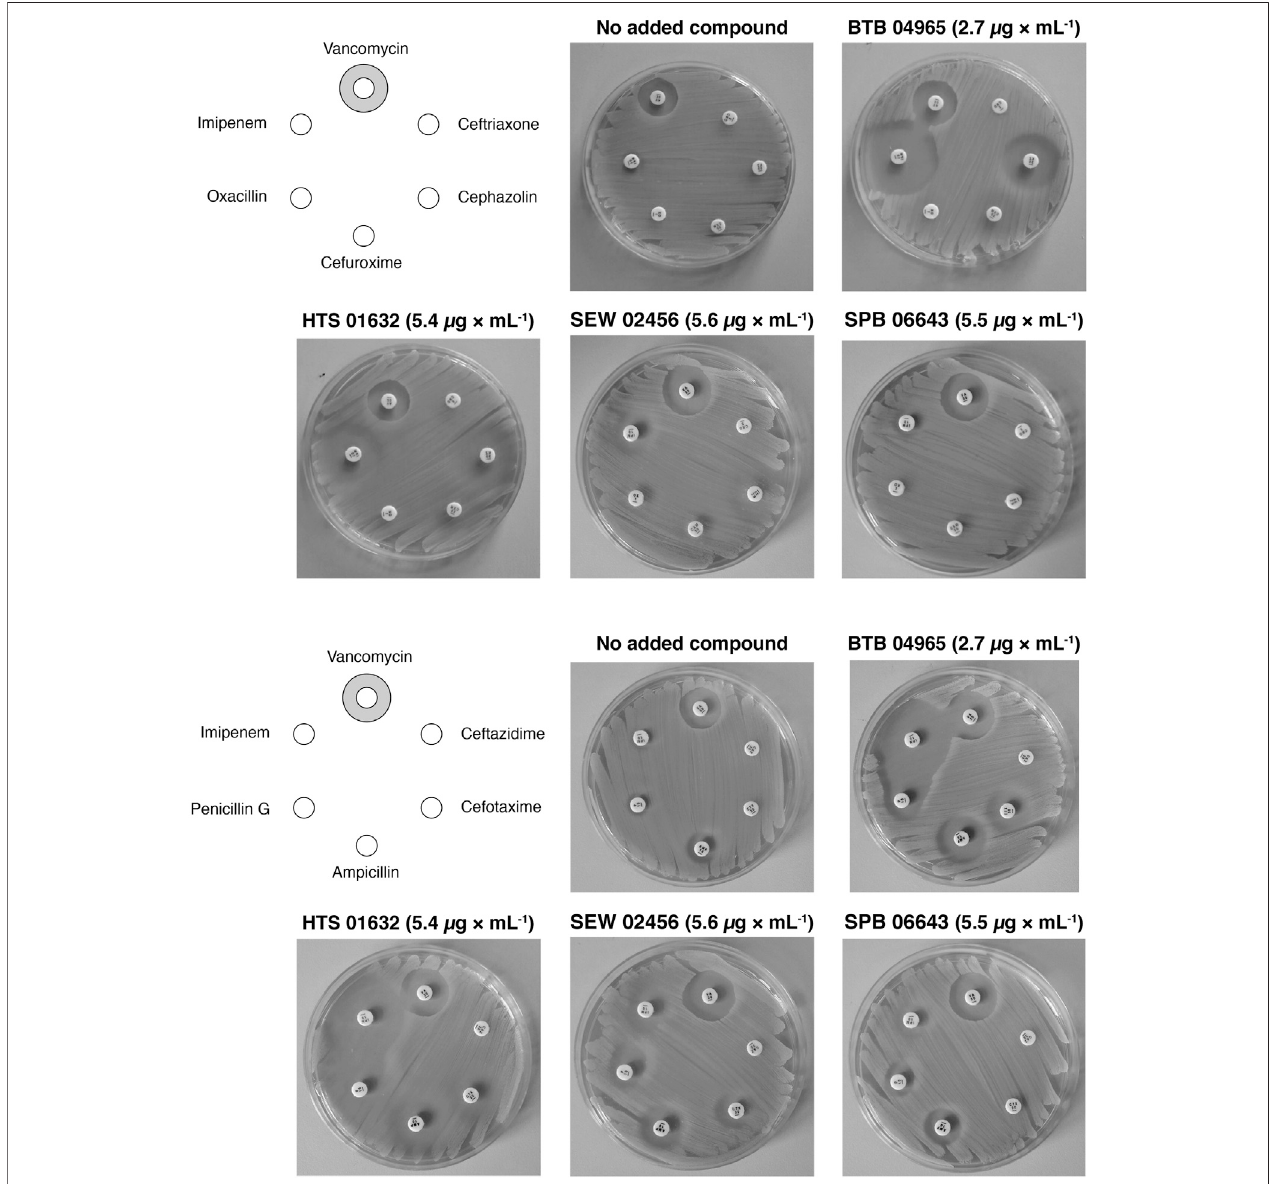
FIGURE3| Reversalof β -lactamresistanceinMRSAstrainCOLbyadditionofhit-compounds. ThesensitivityoftheCOLMRSAstraintowardsdifferent β -lactams and vancomycin (negative control) in the absence or presence of hit-compounds was examined by a disc diffusion assay. Results of the disc diffusion assay performed with four compounds with decreasing ability to increase the growth yield of S. aureus clpX mutants are shown. The hit-compounds were added to the agar at the indicated sub-lethal concentrations, and antibiotic susceptibility discs were placed on a lawn of the MRSA strain COL as indicated on the left diagram.